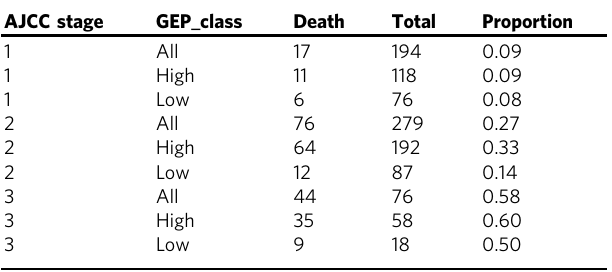
Table 1 Clinical utility of GEP test 5-year melanoma-speci fi c survival (Leeds Melanoma Cohort